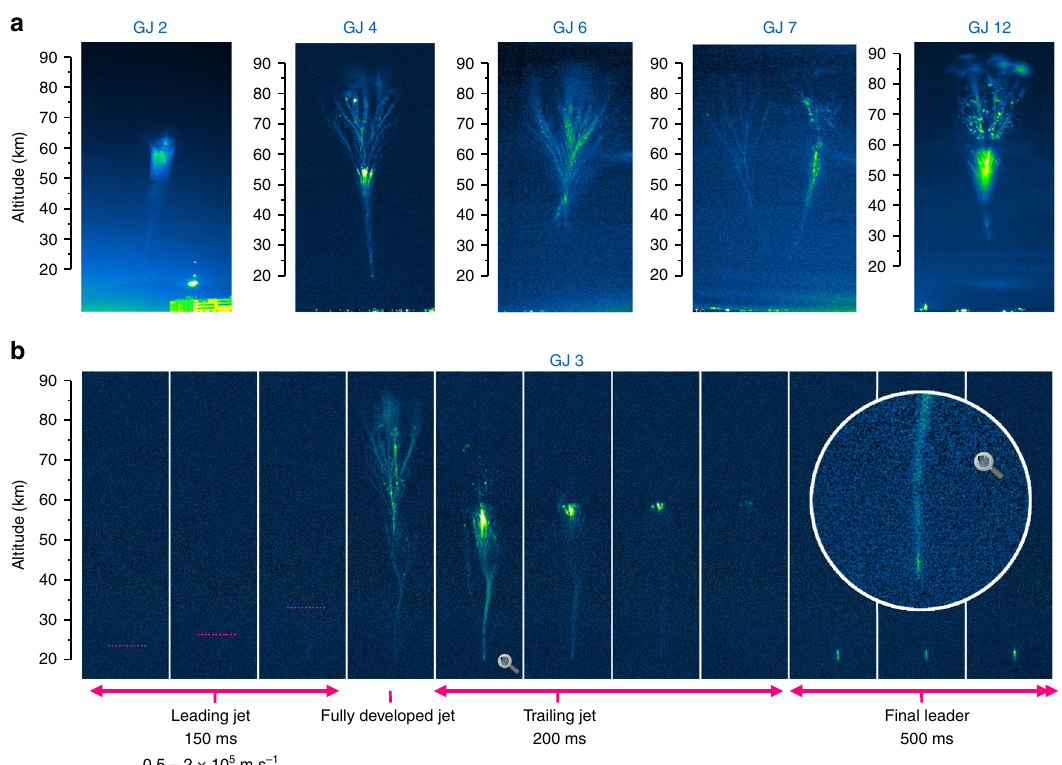
Fig. 1 Five gigantic jets captured from the north coast of Colombia. a Jets recorded from Santa Marta (GJ 2-4), Barranquilla (GJ 7), and Cartagena (GJ 12). b The Leading Jet, Fully Developed Jet, Trailing Jet, and the Final Leader stages are shown for the case of GJ 3 recorded by the 2.3-megapixel camera at 20 images per second. The uneven background was subtracted, horizontal banding noise removed, and contrast enhanced. A close-up of the lower jet and cloud leader section one frame after the FDJ is included in the circular